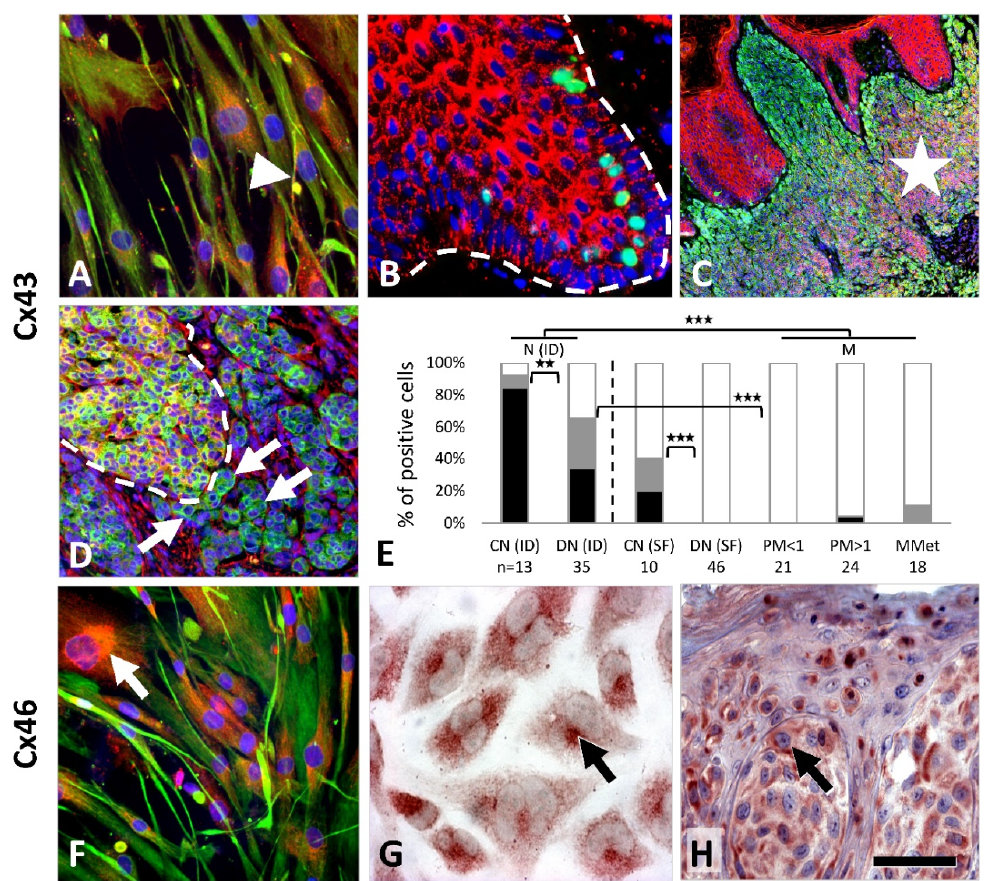
Figure 2. Cx43 ( A – E ) and Cx46 ( F , H ) protein expression (immunofluorescence: red; cell nuclei: blue) in melanocytes and melanocytic lesions. Cultured primary melanocytes show granular cytoplasmic and cell membrane (arrowhead) staining ( A ; vimentin intermediate filaments: green). Dense granular signal is seen in melanoma adjacent epidermal hyperplasia between keratinocytes and less surrounding all cells in the basal epidermal layer (along the broken line) including melanocytes ( B ; Ki67 positive proliferating keratinocytes: green). Strong reaction in the middle and basal regions in line with maturation in a common nevus ( C ; asterisk, melan A : green). A Cx43 positive nevus nest (within broken line) and adjacent stromal cells with Cx43 negative atypical tumor cells (arrows, melan A : green) in a nevus-based melanoma ( D ). Cx43 expression in common (CN) and dysplastic nevi (DN), in thin (PM < 1) and thick (PM > 1) primary as well as in metastatic (MMet) melanomas (*** p ≤ 0.001; ** p ≤ 0.01) ( E ). ID, intradermal; SF, superficial; black, >25%, gray, 5–25%, white, ≤5%. Cx46 immunoreactions show paranuclear (ER-Golgi) accumulation (arrows) in cultured melanocytes ( F ; vimentin: green), in HT199 metastatic melanoma cell line ( G ) and in a nodular melanoma ( H ). In immunoperoxidase reactions AEC (3-amino-9-ethylcarbazole, red) chromogen was used. Scale bar on H represents 40 μm on A and F ; 50 μm on B and H ; 150 μm on C , 80 μm on D , and 20 μm on G . Cx32 ( GJB1 ) protein was detected both in the vertical growth phase WM983/A (Figure 3A) and in the metastatic melanoma lines A2058 and HT199 as a granular and/or diffuse cytoplasmic reaction, while primary melanocytes were negative. In tissue sections, moderate cytoplasmic Cx32 signals were seen in 62/70 (89%) nevi and 65/67 (97%) melanomas. Membranous Cx32 localization was observed in 6/16 (38%) common nevi versus 6/54 (11%) dysplastic nevi ( p = 0.023) (Figure 3B) and in 7/67 (10%) melanomas (including metastases). Paranuclear Cx32 staining was found in 8/27 (30%)